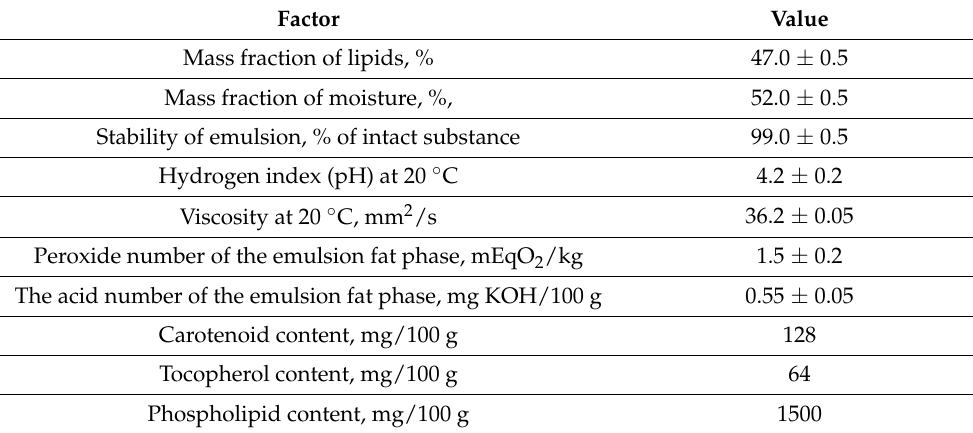
Table 8. Quality